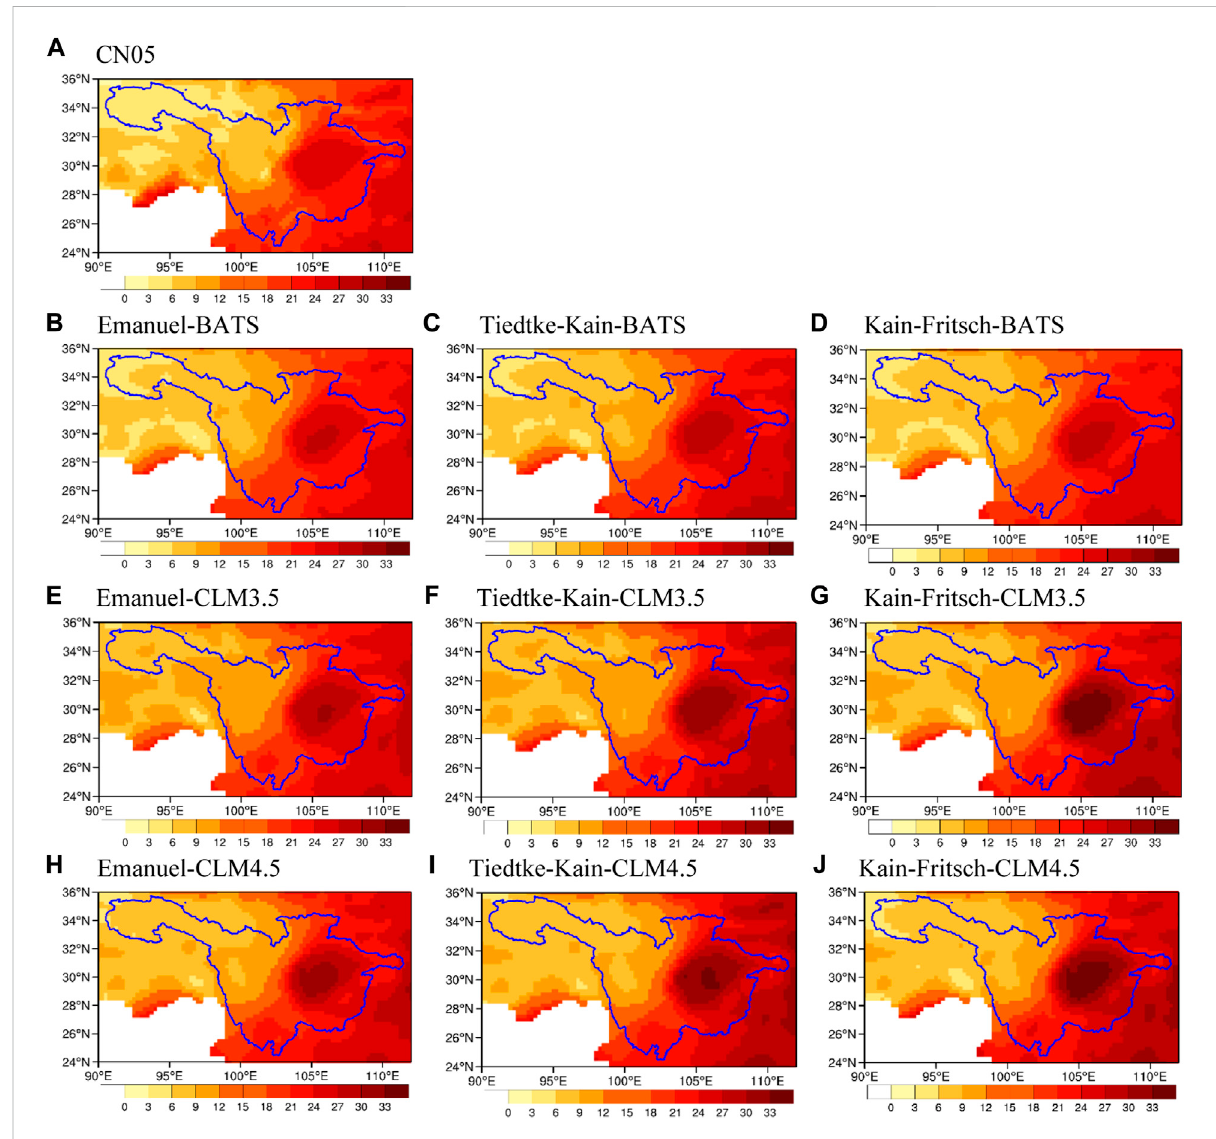
FIGURE 5 Spatial distribution of observed and simulated multi-year summer average temperature (unit: ° C) for the current climate (1991 – 1993) over the UYRB. [ (A) CN05, (B) simulation of the combination scheme of Emanuel and BATS, (C) simulation of the combination scheme of Tiedtke-Kain and BATS, (D) simulation of the combination scheme of Kain-Fritsch and BATS, (E – G) same as (B – D) but for CLM3.5, and (H – J) same as (B – D) but for